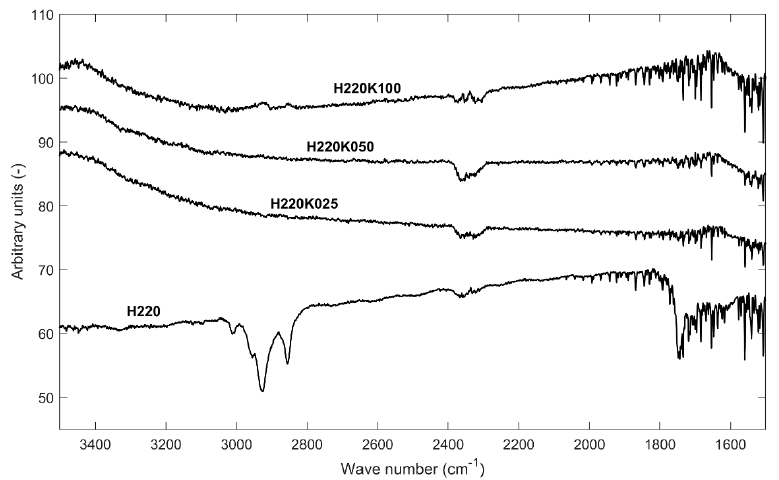
Figure 6. FTIR spectra of hydrochar before activation (H220) and GSAC samples.